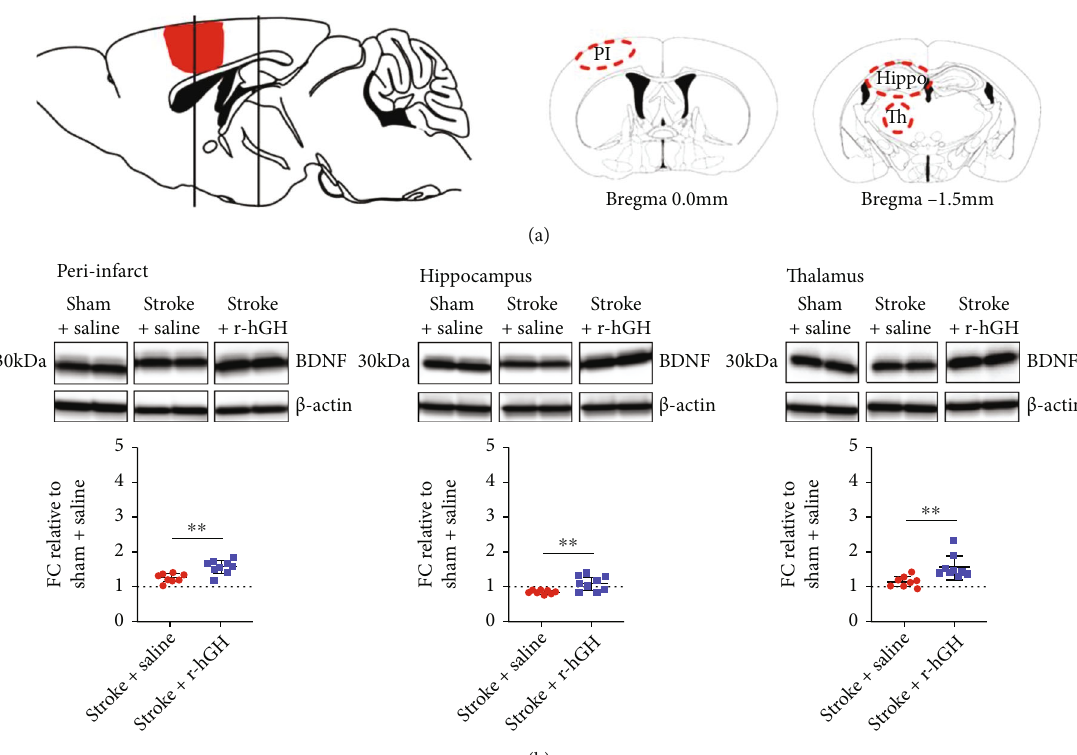
Figure 1: The e ff ect of recombinant human growth factor (r-hGH) treatment poststroke on uncleaved immature form of brain derived neurotrophic factor (pro-BDNF, p-BDNF) expression. (a) Sagittal diagram shows the location of photothrombotic stroke induction (red area) at Bregma 0.0mm. The black lines represent the location of tissue collection from the peri-infarct cortex at Bregma 0.0mm as well as the hippocampus and thalamus at Bregma -1.5mm. Coronal slices (mid and right panels) are also shown at 0.0mm with peri-infarct region and -1.5mm with hippocampus and thalamus regions. Red circles represent the area selected for western blot analyses. (b) Representative blots of pro-BDNF and β -actin in the top panels for peri-infarct, hippocampus, and thalamus. Loading controls were performed by loading equal amounts of total protein and also were normalized to β -actin. Levels were expressed as a fold change (FC) of mean ± SD for each group relative to the mean of the Sham+Saline group (dotted line), shown in the bottom panels for each location. We found a signi fi cant increase in pro-BDNF within the peri-infarct, hippocampus, and thalamus in stroked mice treated with r-hGH (blue squares) compared with saline (red circles). ∗∗ p < 0 : 01 , 2-tailed t -test. Table 1: List of antibodies used for western blot analyses. Sources of antibodies Dilution BDNF Santa Cruz, polyclonal rabbit anti-BDNF (precursor and mature), sc-546